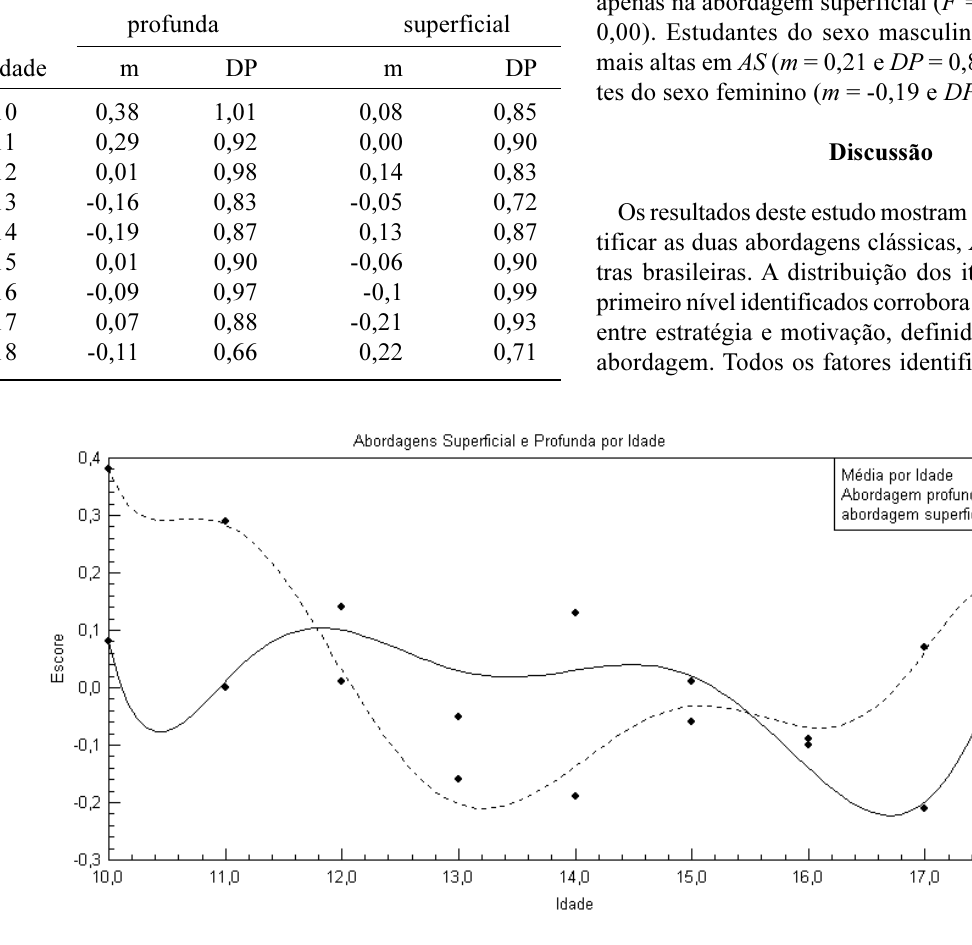
Figura 2 . Média de Desempenho nas Abordagens por